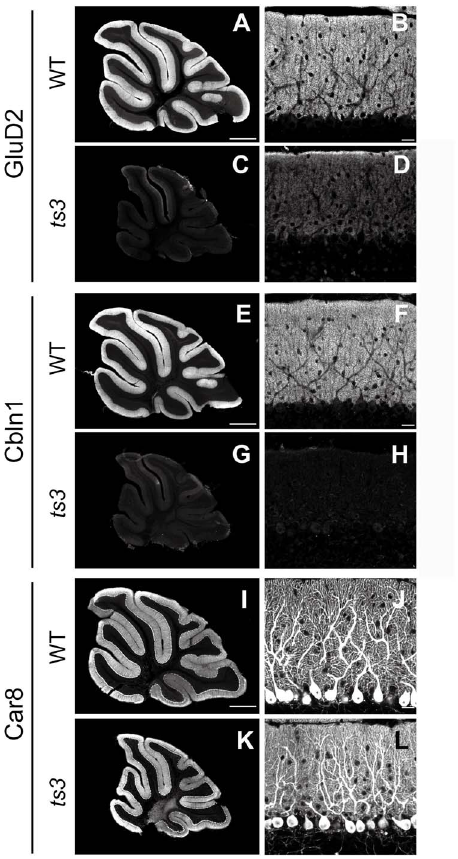
Figure 9. Severe reduction of GluD2 and Cbln1 immunoreac- tivities in ts3 mutants. (A-L) Immunohistochemistry for GluD2 (A-D), Cbln1 (E-H) and Car8 (I-L) in control (A, B, E, F, I, J) and ts3 mutants (C, D, G, H, K, L). Scale bars, A, E, I, 500 m m; B, F, J, 20 m m.